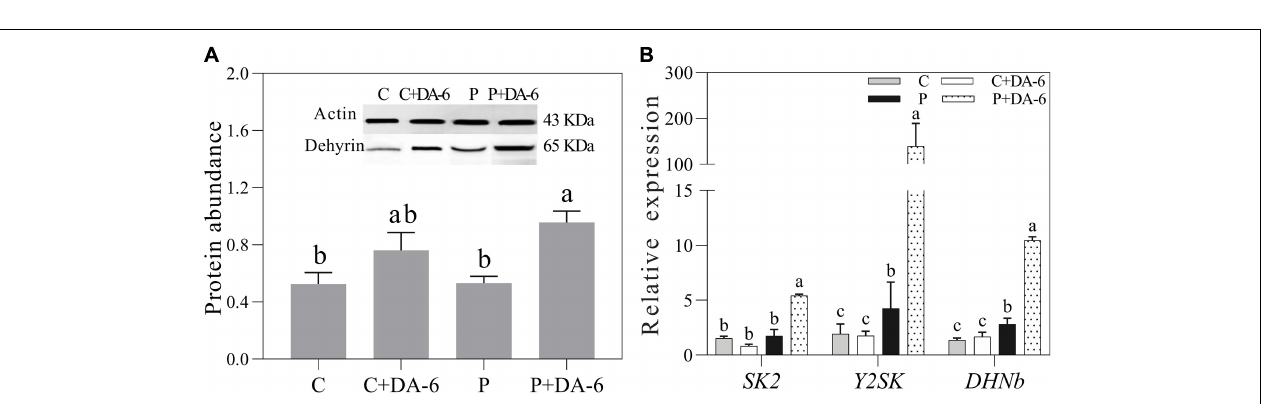
FIGURE 7 | Effect of seed priming with distilled water or DA-6 (2mM) on (A ) superoxide dismutase (SOD), (B) peroxidase (POD), (C) catalase (CAT), and (D) ascorbate peroxidase (APX) activities after 3 and 7 day of germination in white clover, whereas (E) shows expression level of antioxidant encoding genes after 3 days under well-watered condition and drought stress. Different letters above different treatments represent significant differences at a specific time point under normal condition or drought stress ( p ≤ 0.05). Vertical bars show the ± SE of mean ( n = 4).